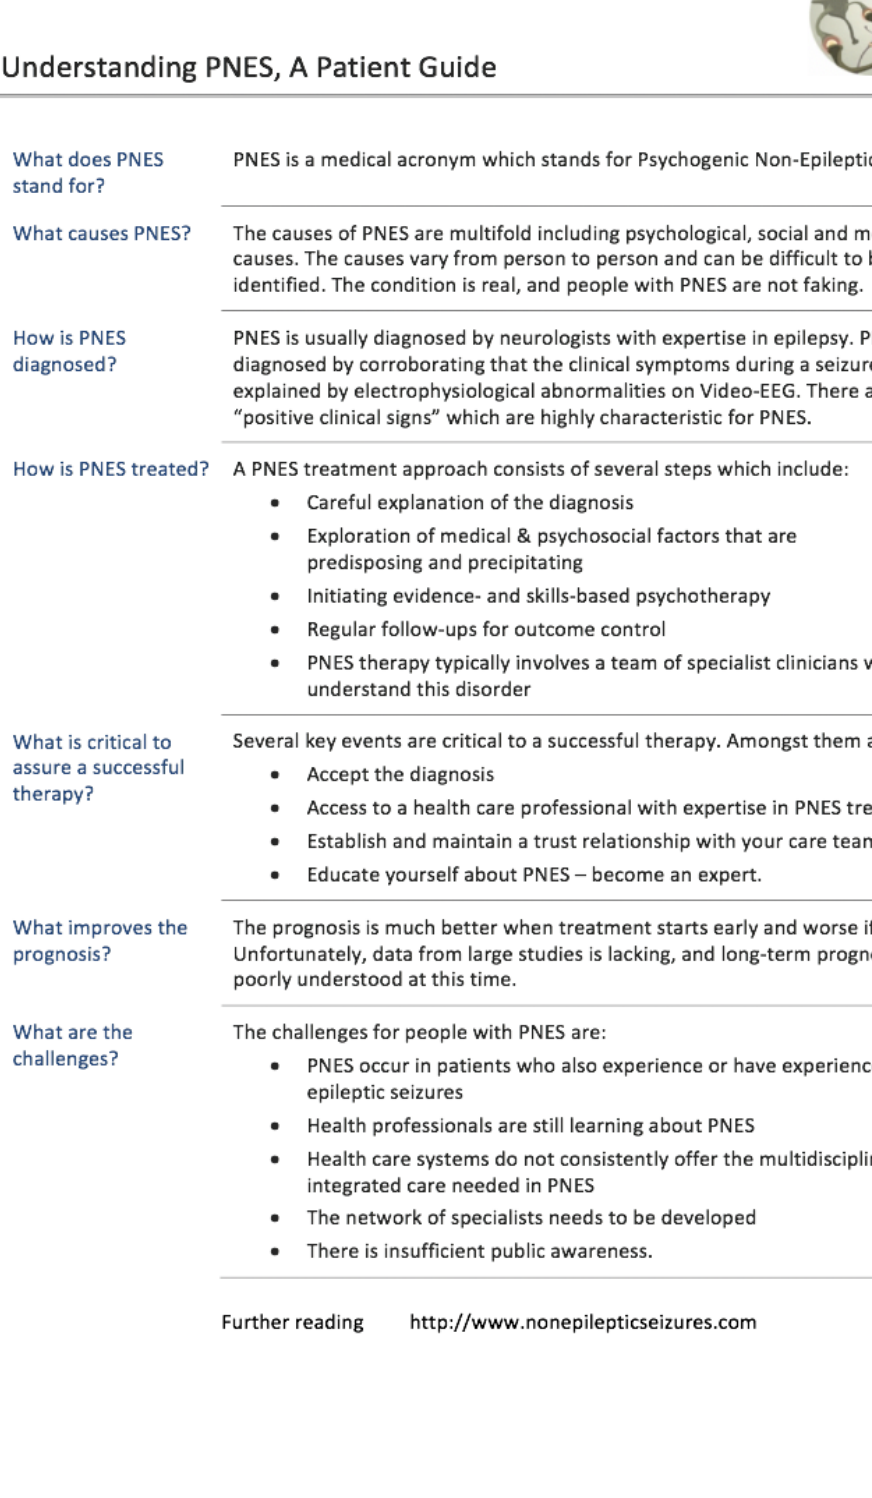
Figure 3. Document-engineering methodology (DEM)-1-pager for psychogenic nonepileptic seizures (PNES) (version 4); a tool for early communication of PNES created in a design-thinking process with patient engagement